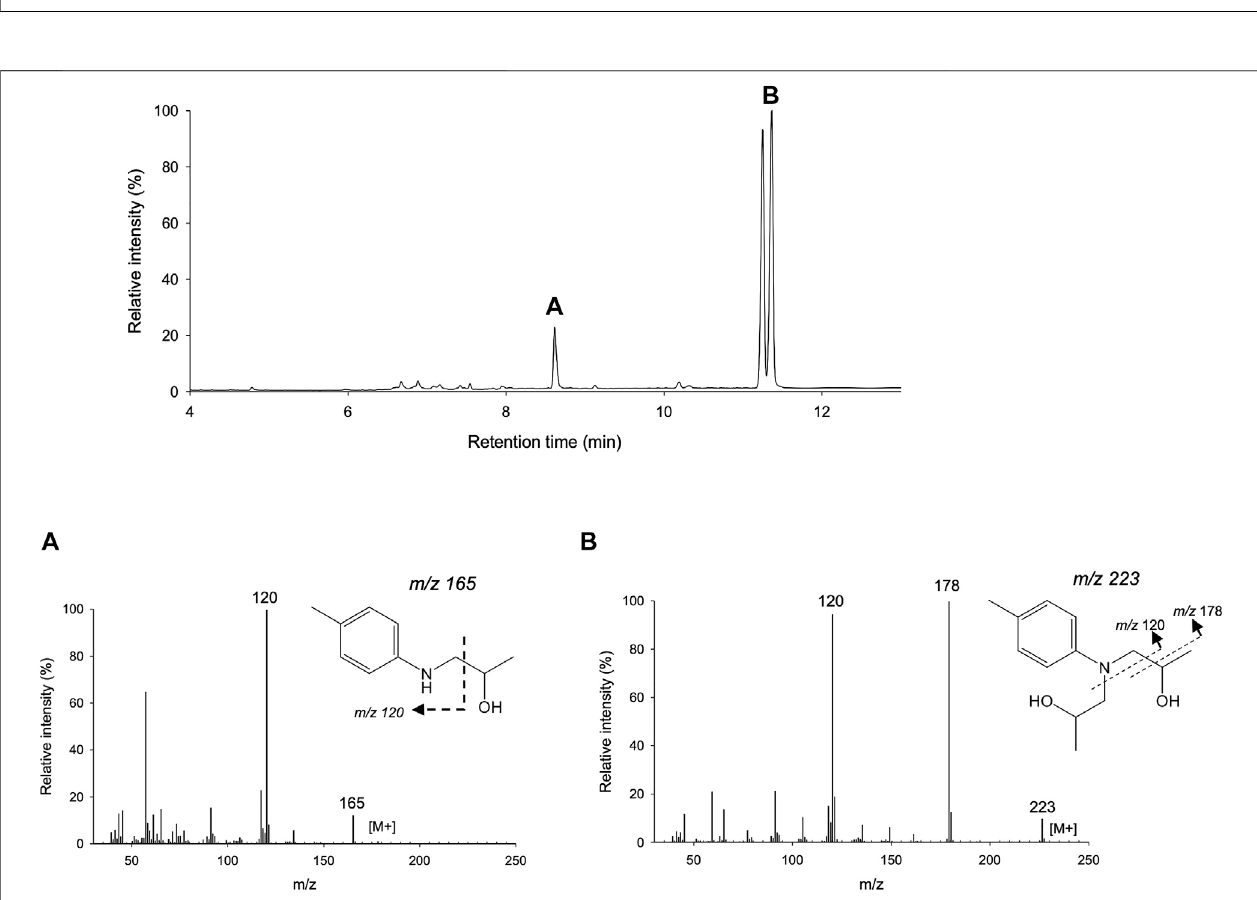
FIGURE2| GC/MSchromatogramofthereaction withNNBT.ThechromatographiccolumnwasSH-Rxi-5ms andthemethoddescriptionwas(120/1/20/260/5). Samples were extracted with AcOEt and dried with MgSO 4 before analysis. (A) Dealkylation product ( N -isopropanol- p -toluidine) mass spectra which peak appears at 8.6 min. (B) NNBT mass spectra where both diastereomers can be observed at 11.2 min and 11.3 min.